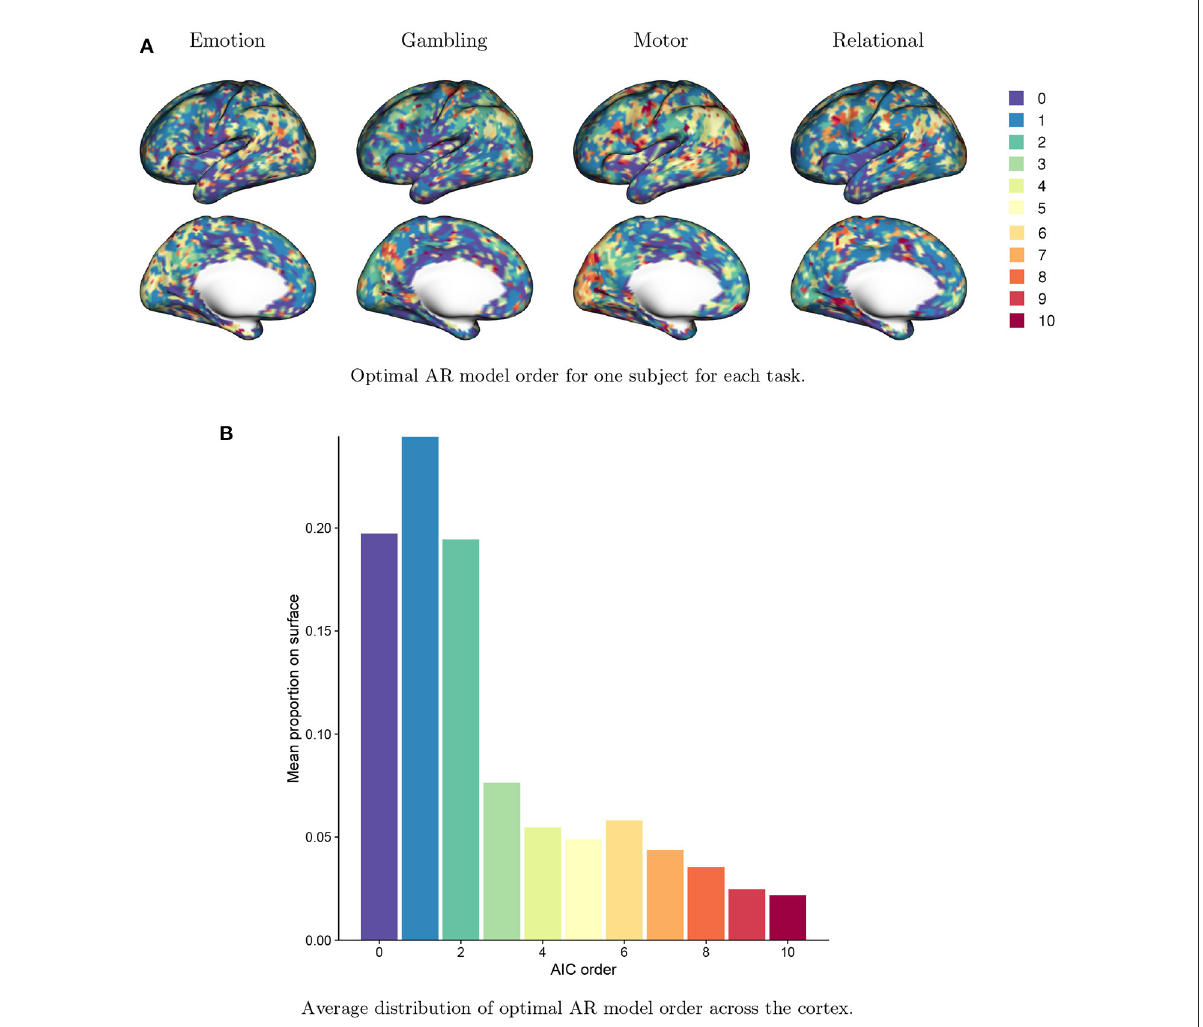
FIGURE8 Optimal AR model order across the brain based on the Akaike information criterion (AIC). (A) The optimal AR model order at every vertex for a single subject for each task. The optimal order clearly varies across the cortex and with the task being performed. (B) The distribution of optimal AR model order across all vertices, averaged over all subjects, sessions and tasks. The optimal AR model order is two or less for most vertices, but over 20 % of vertices have optimal AR model order of 3–6, while over 10 % have optimal order of 7 or higher.